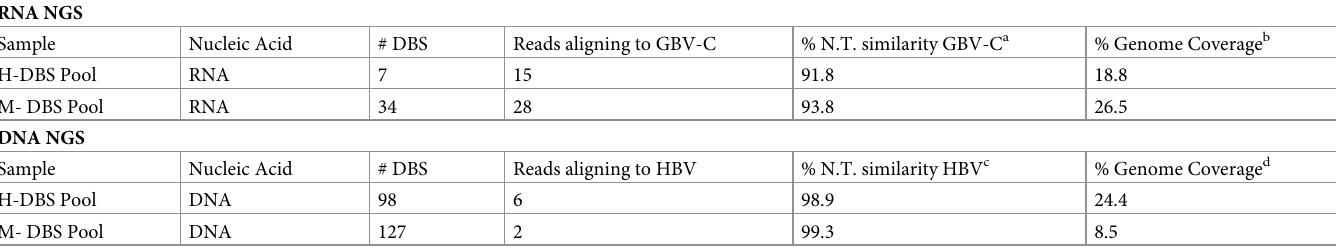
Table 2. NGS reads aligning to human